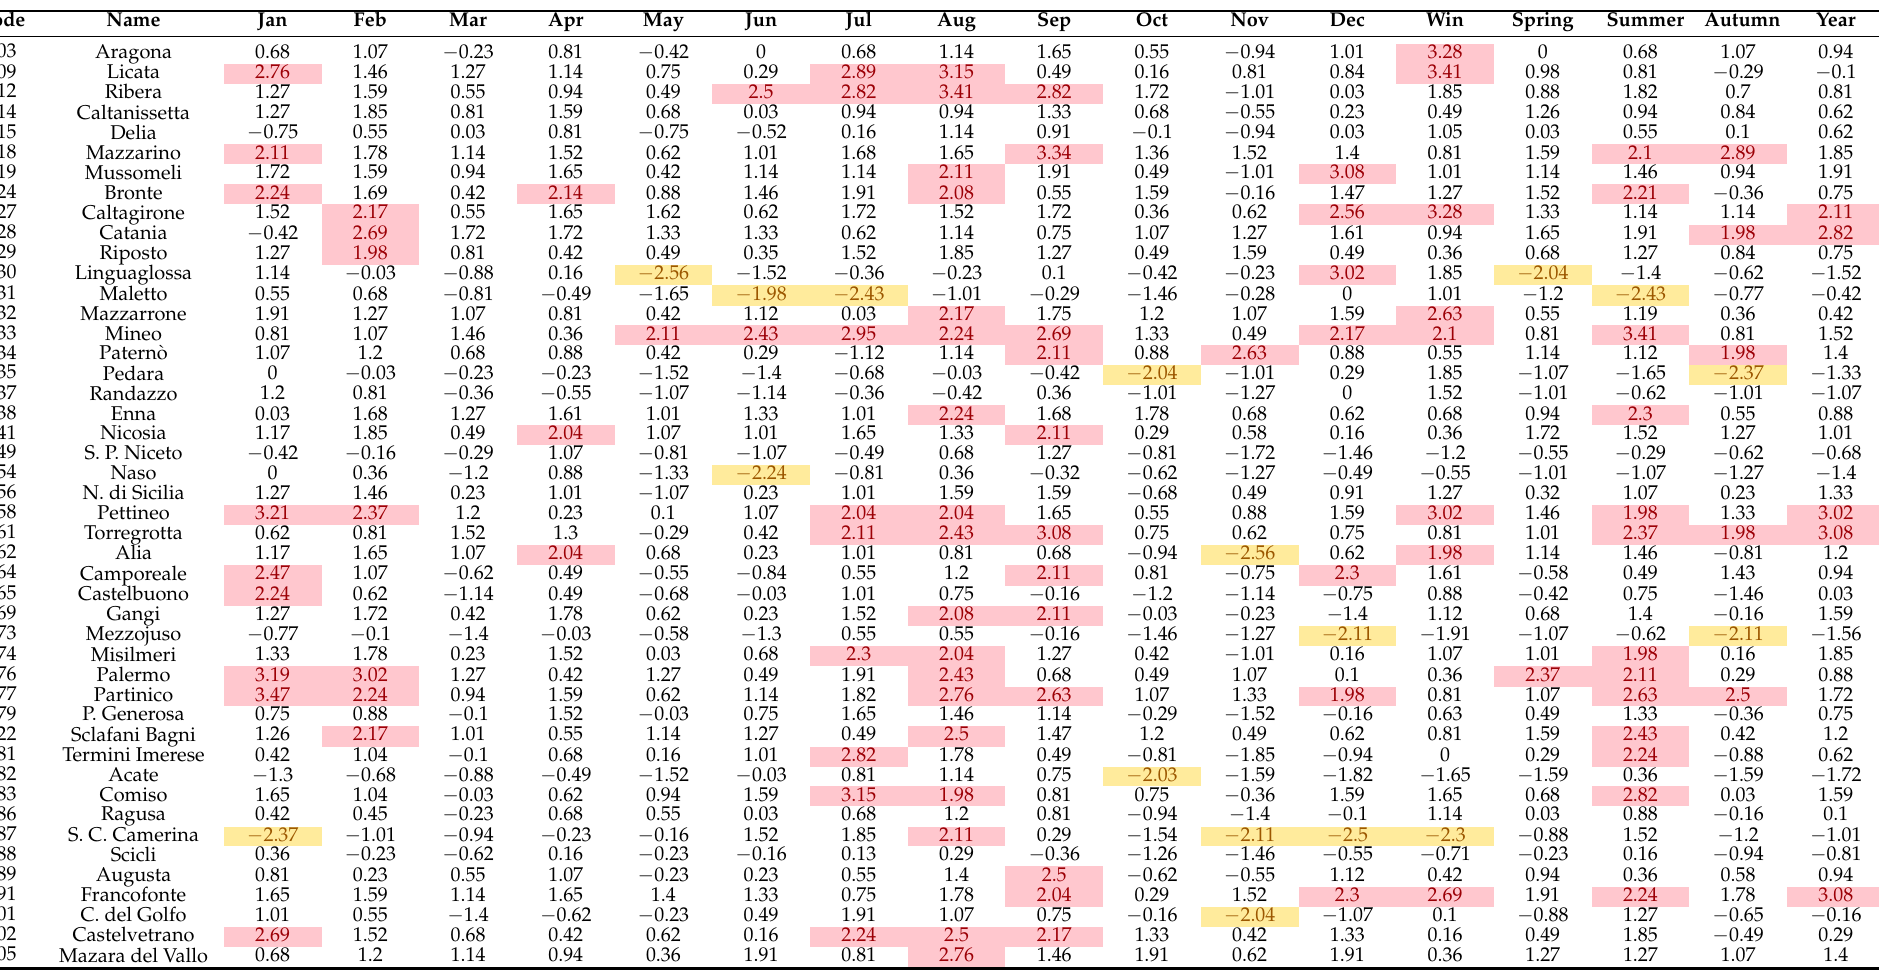
Table 2. Z value of the PET trend for each meteorological station at different temporal scales. Yellow shading represents the Z value decreasing PET trend, whereas the reddish shading is the Z value increasing PET